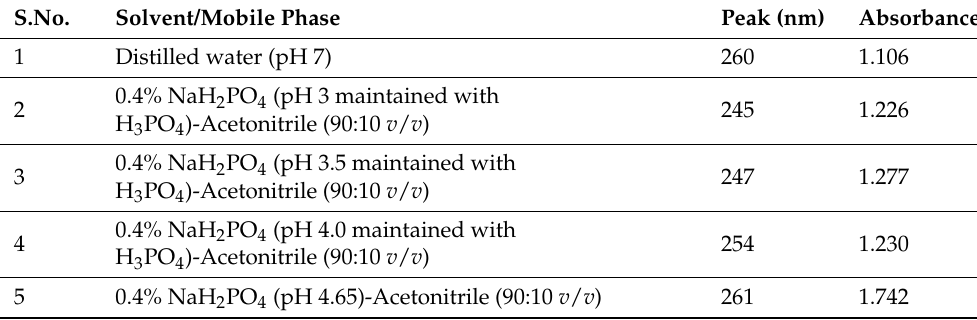
Table 1. Absorbance and peak of 20 µ g mL − 1 ascorbic acid in distilled water and mobile phases of different